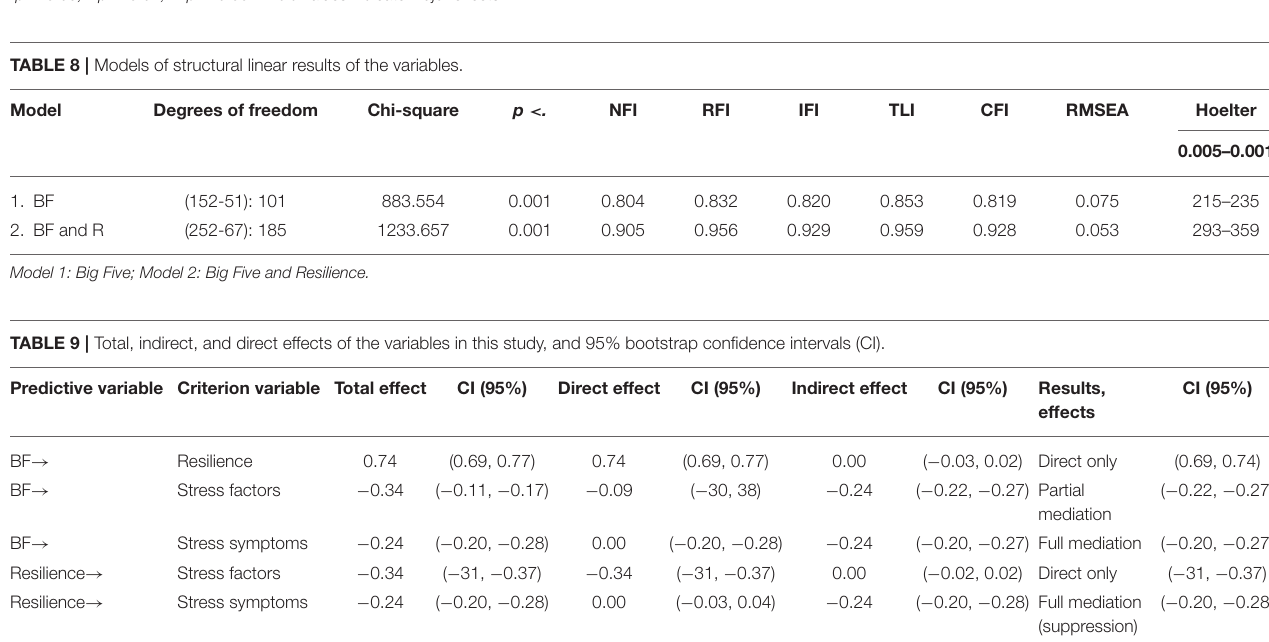
Figure 1 shows general prediction relationships of the model. The Big Five personality factors, except for Neuroticism (N) ( B = − 0.27), are positive predictors of resilience (RES). The proactive components of resilience (competence, change and control), as well as its reactive components (stress management and spirituality), are negative predictors of stress factors (STRESSFACT), although spirituality shows less weight in this prediction (SPIRIT) ( B = 0.17). The general mediating effect of resilience is thereby demonstrated. Stress factors may originate in aspects of the teaching process as well as the learning process; they are positive predictors of academic stress symptoms (STRESSSYMT). However, this general